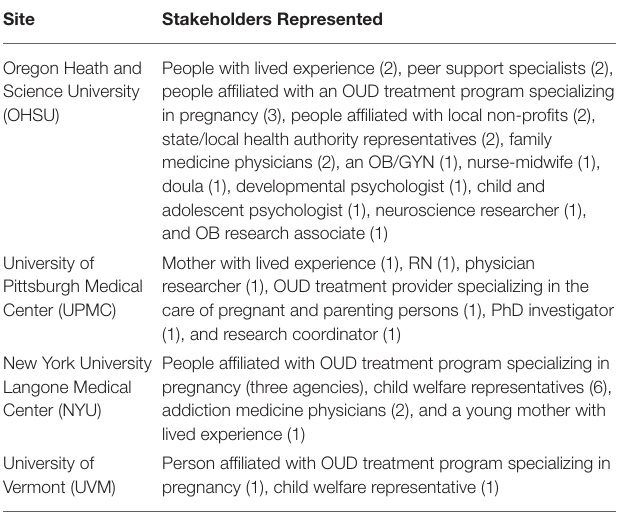
TABLE 1 | Composition of stakeholder meetings by